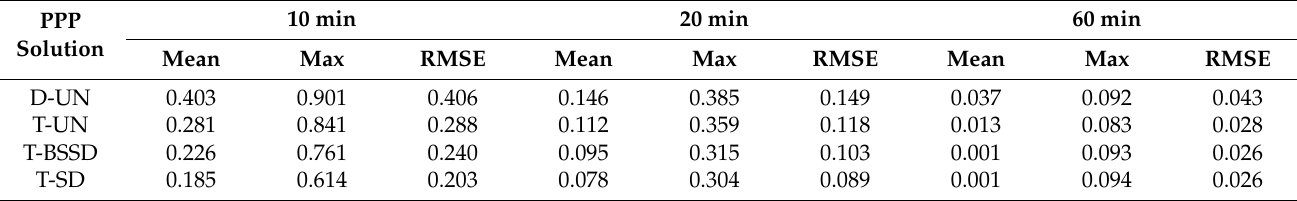
Table 3. Statistical parameters of 3D position accuracy for different PPP solutions (in